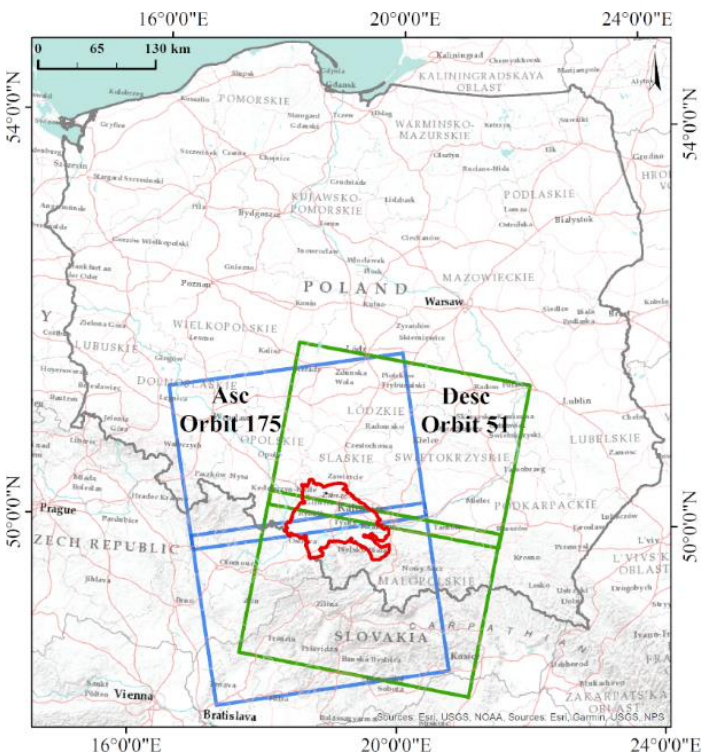
Figure 2. Ascending (blue) and descending (green) orbit footprints of Sentinel-1 data used in this study over the territory of the Polish part of Upper Silesian Coal Basin (USCB).